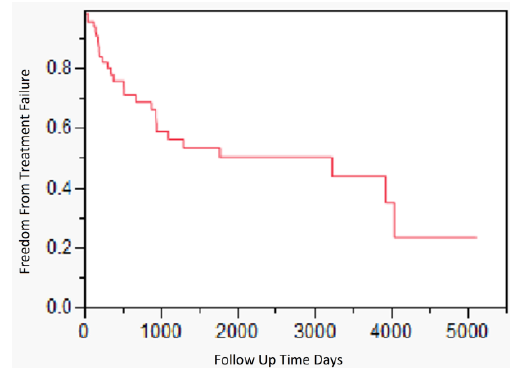
Figure 1. Kaplan-Meier time dependent analysis assessing the outcome of 102 Pseudomonas PJI episodes seen at the Mayo Clinic between 1969 and 2012.